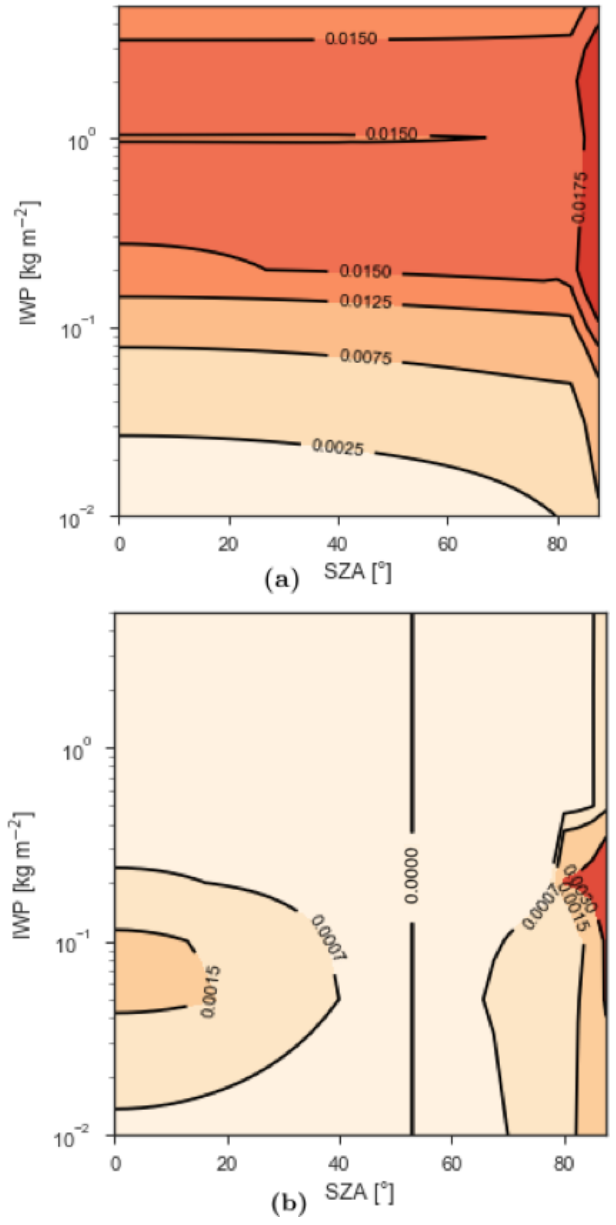
Figure 6. Weighted RMSE as a function of IWP and SZA, for LWP=0.1kgm − 2 , (a) if the dependency of RWs on IWP and SZA is neglected, with RWs valid for IWP=0 and LWP=0.1kgm − 2 ; and (b) if the SZA dependency of RWs is neglected and taken at SZA=53 ◦ .